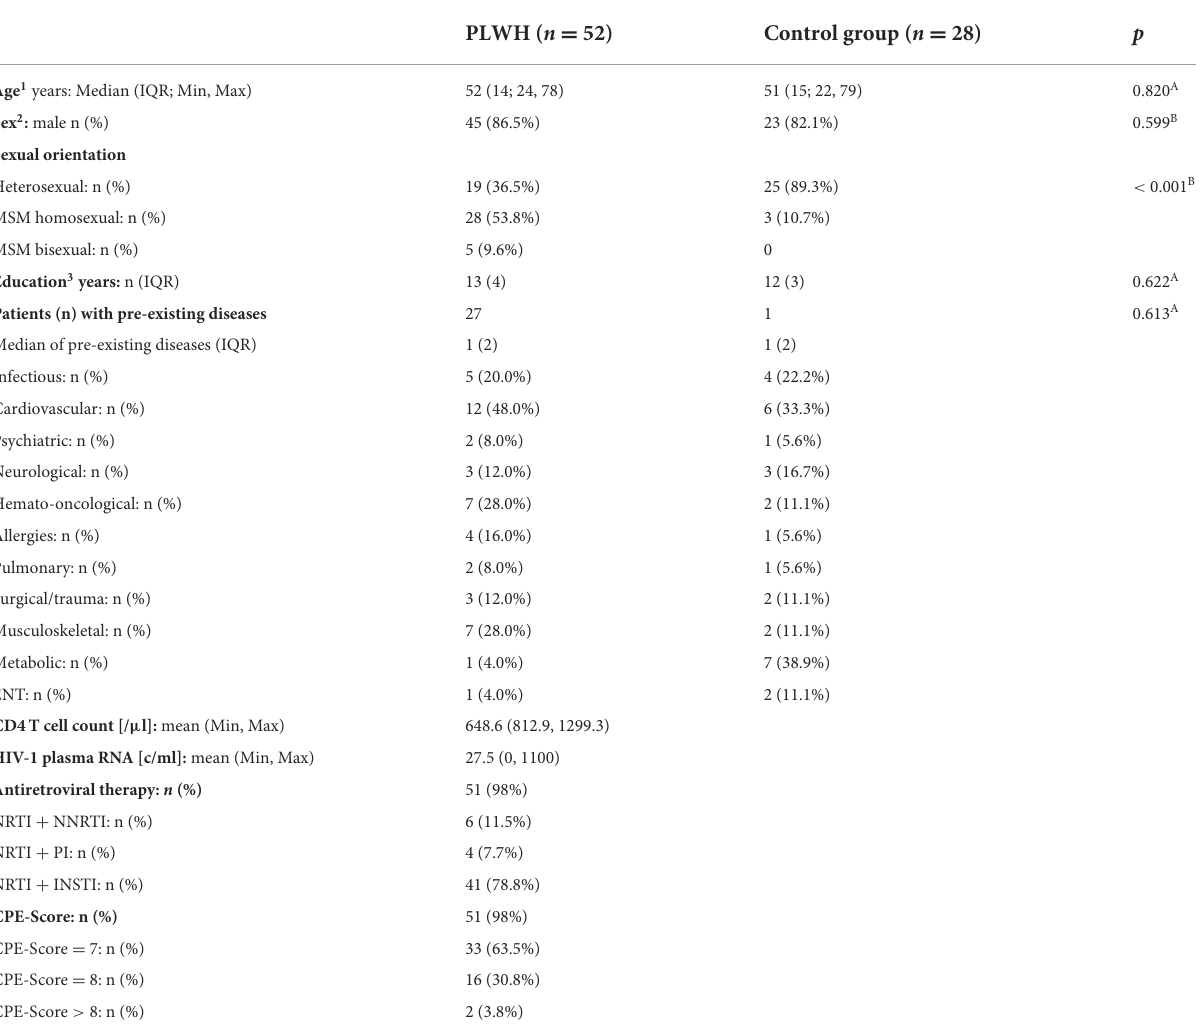
TABLE 1 Patients and probands